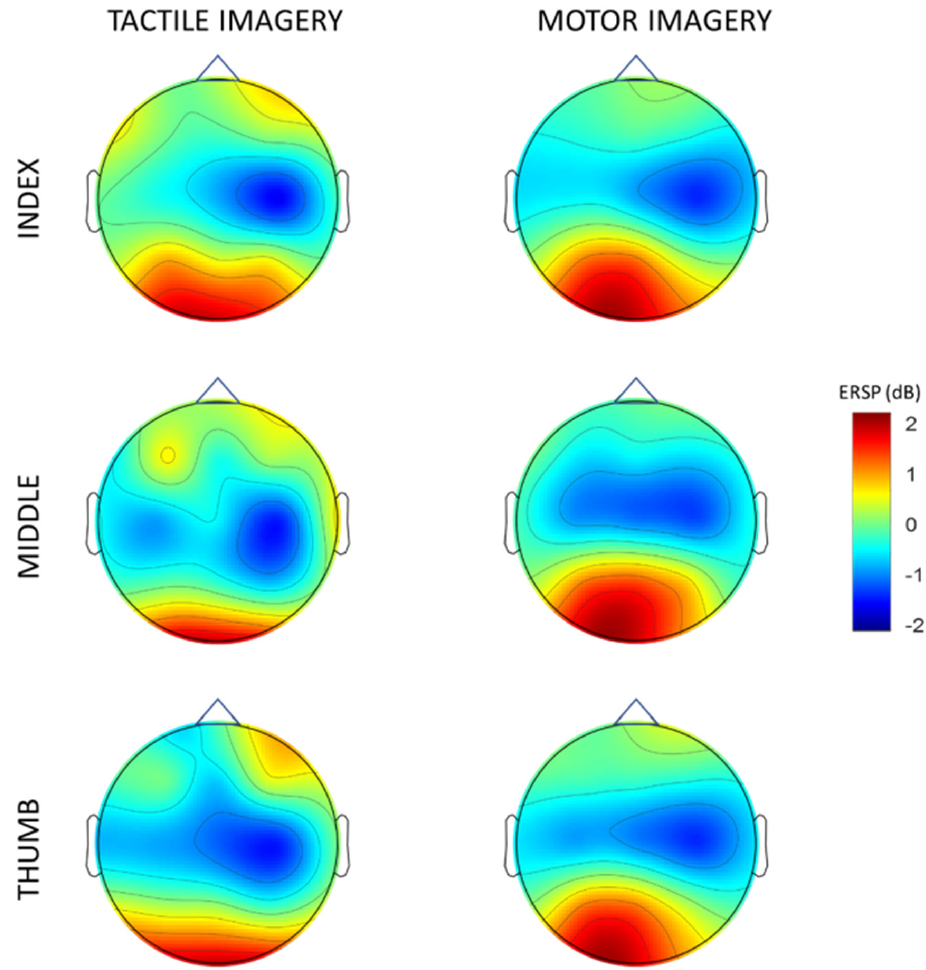
Figure 3. Averaged topographical distribution of power. Blue indicates ERD. A repeated-measures ANOVA was applied to study the differences between TI vs.